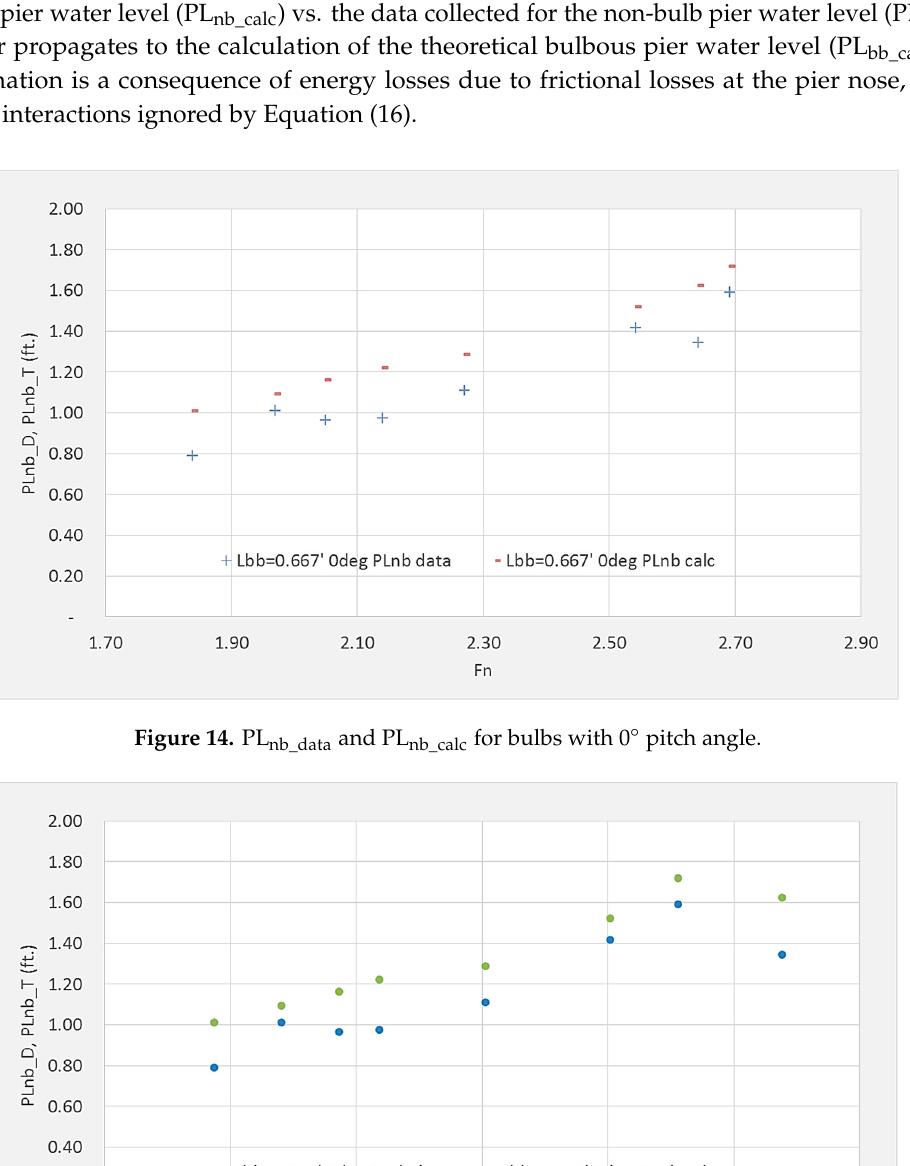
Figure 16. PL bb_data and PL bb_calc for bulbs with 10° pitch angle.